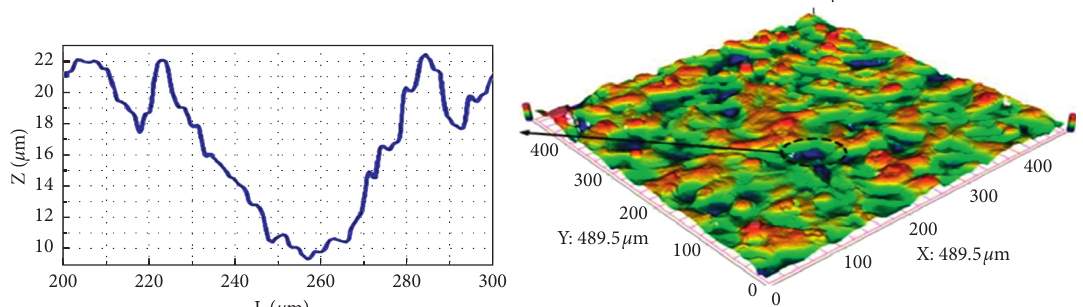
Figure 3: 3D micrometer surface morphology with different discharge energies: (a) I